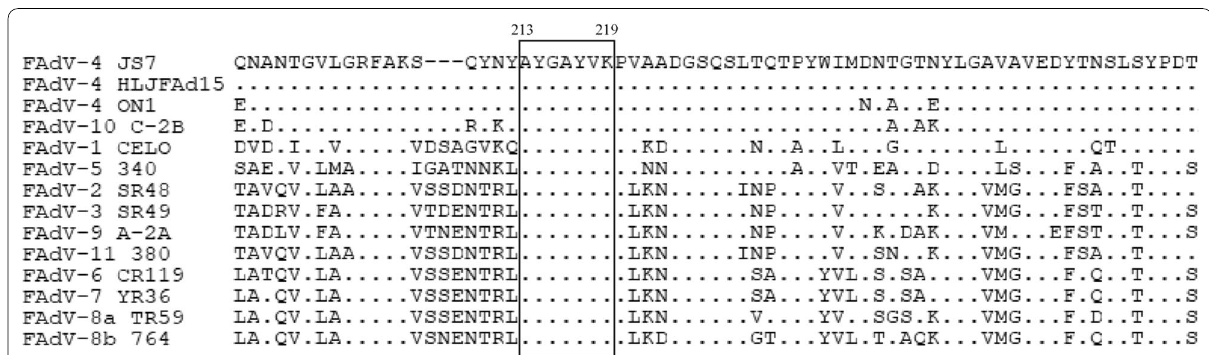
Fig. 4 Amino acid alignment of the epitope in Hexon of FAdVs. The amino acid sequence of FAdV-4 JS7 containing the identified epitope was compared with those in 12 serotypes of FAdVs. The sequences used here are FAdV-4 strain JS7 (AUD07657.1), FAdV-4 strain HLJFAd15 (APA19522.1), FAdV-4 strain ON1 (ADQ39061.1), FAdV-1 strain CELO (AAC54912.1), FAdV-2 strain SR48 (ANJ02381.1), FAdV-3 strain SR49 (ANJ02418.1), FAdV-5 strain 340 (YP_007985654.1), FAdV-6 strain CR119 (ANJ02455.1), FAdV-7 strain YR36 (ANJ02492.1), FAdV-8a strain TR59 (ANJ02529.1), FAdV-8b strain 764 (ANJ02566.1), FAdV-9 strain A-2 A (NP_050287.1), FAdV-10 strain C-2B (ALE15153.1), and FAdV-11 strain 380 (ANJ02603.1). The identified epitope was shown in